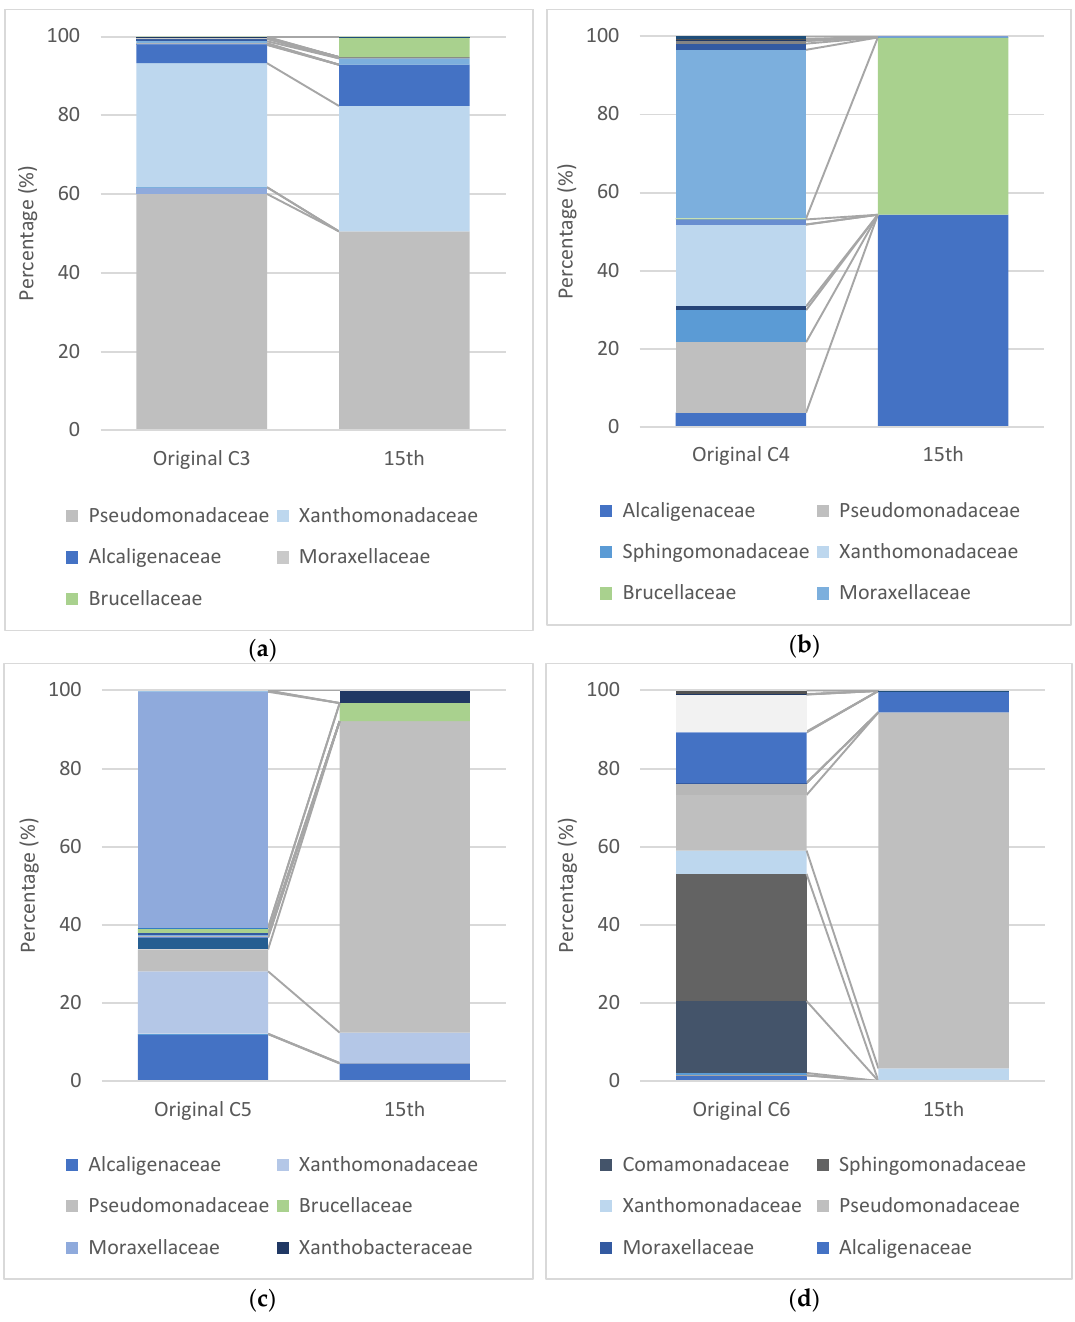
Figure 3. NGS profile of the consortia ( a ) C3, ( b ) C4, and ( c ) C5 enriched from WWTP near the beach; and ( d ) C6 from an oil refinery company. The predominant family was Pseudomonadeceae , Xanthomonadaceae , Alcaligenaceae , Moxarelaceae , and Brucellaceae .